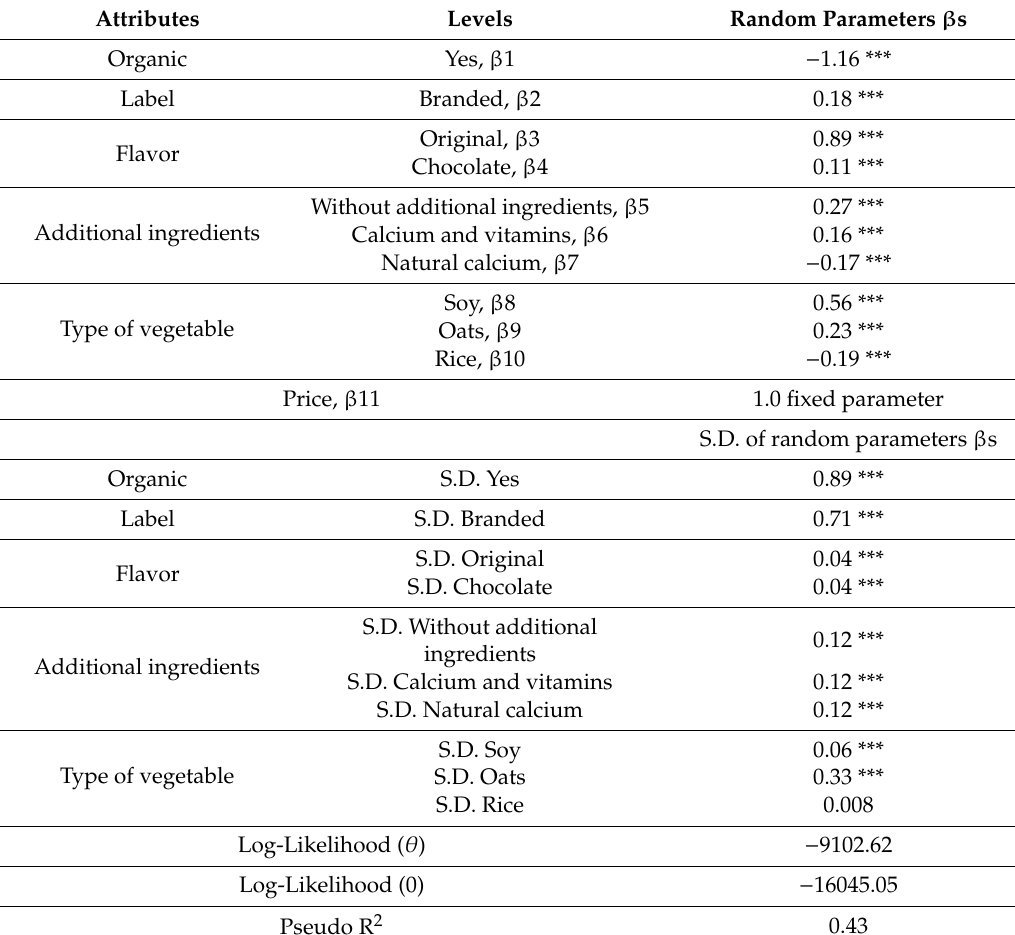
Table 2. Estimates for models parameterized in willingness to pay (WTP)